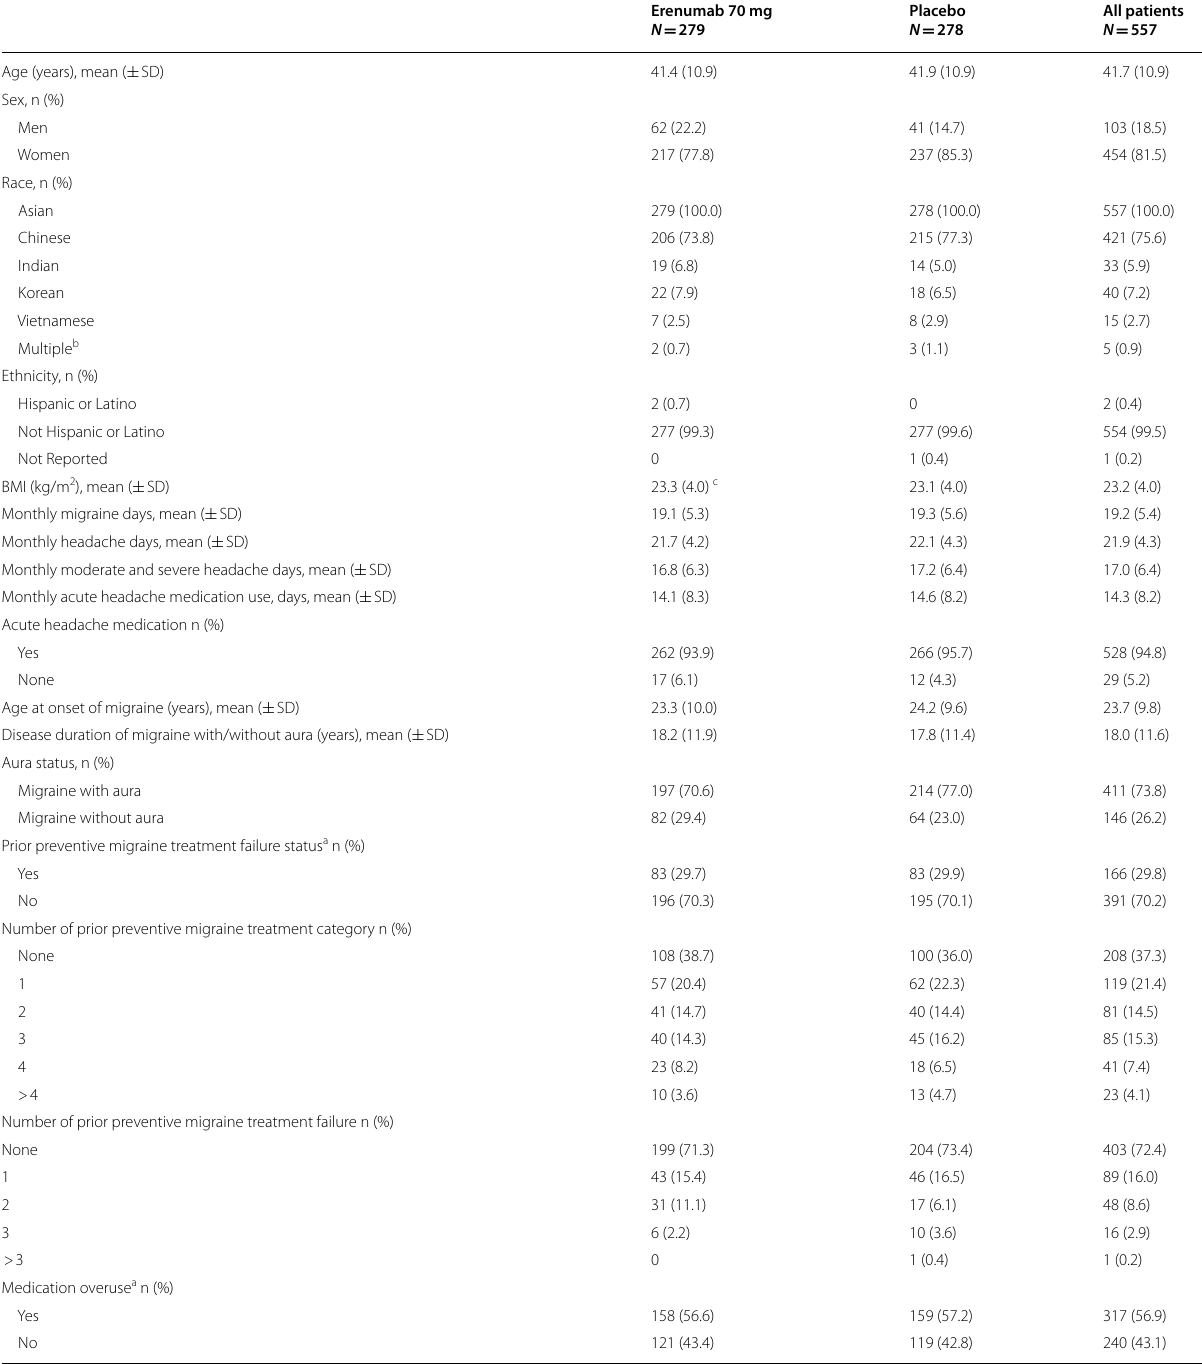
Table 1 Patient demographics and baseline disease characteristics (Full analysis